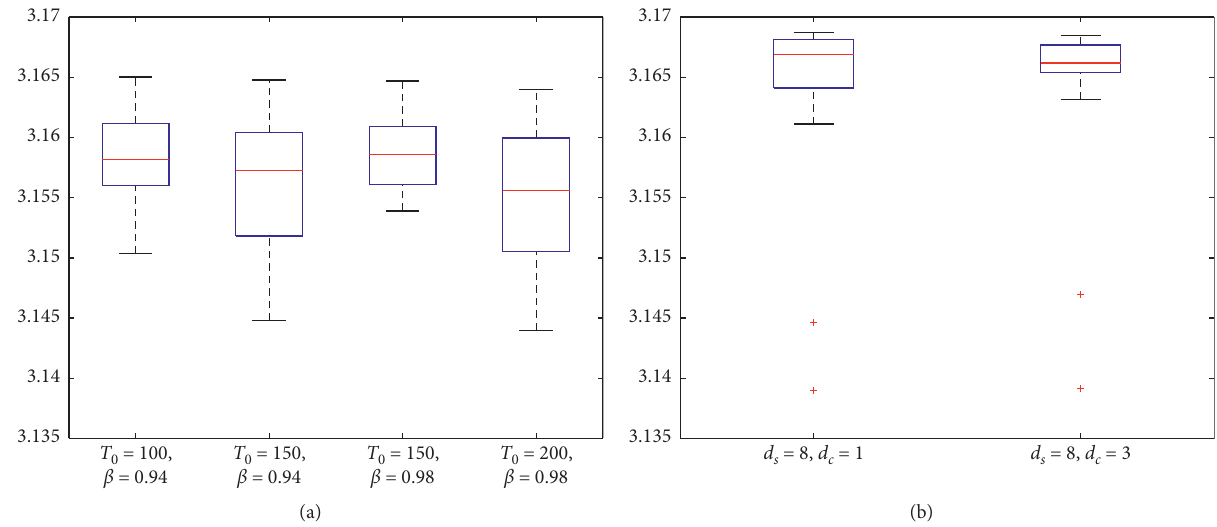
Figure 9: Example 2: the boxplots of the volume of the obtained hyperbox. (a) SA-DIRECT method and (b) d CMA-ES-DIRECT